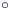
The layout of the sensors and source.“○” represents the sensors, “” represents the acoustic source.